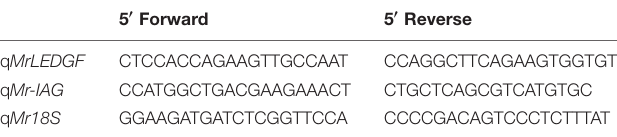
TABLE 2 | Primer sequences for